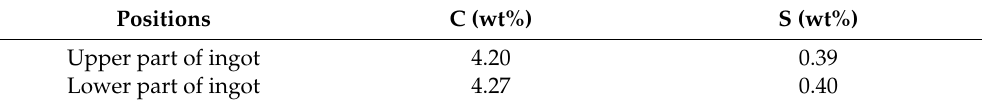
Table 2. C and S contents in the sulfur-containing iron analyzed by a carbon-sulfur analyzer. Positions C (wt%) S (wt%) Upper part of ingot 4.20 0.39 Lower part of ingot 4.27 0.40